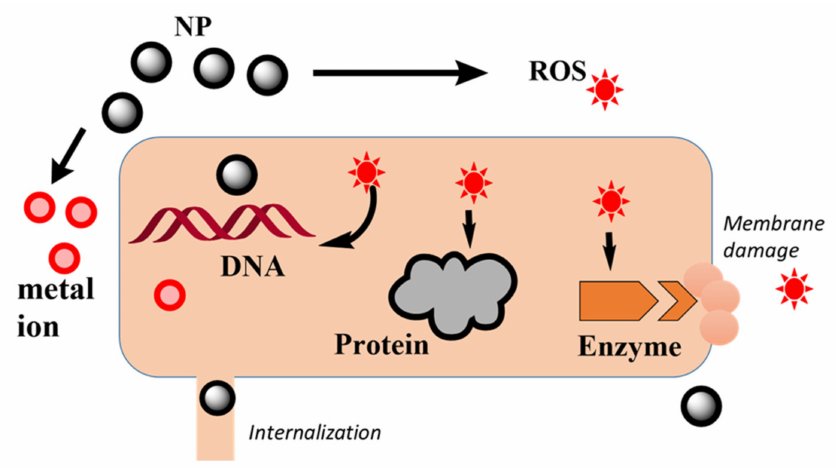
Figure 7. Metal oxide nanoparticles can release metal ions and reactive oxygen species (ROS), two important components that interact strongly with microbial protein, DNA, biomolecules, and enzyme activity that support cell growth and proliferation. ROS encompassing . OH • , 1 O 2 , H 2 O 2 , and superoxides (O 2 − ) invoke oxidative lesions, oxidative stress, and membrane lipid peroxidation to damage proteins and nucleic